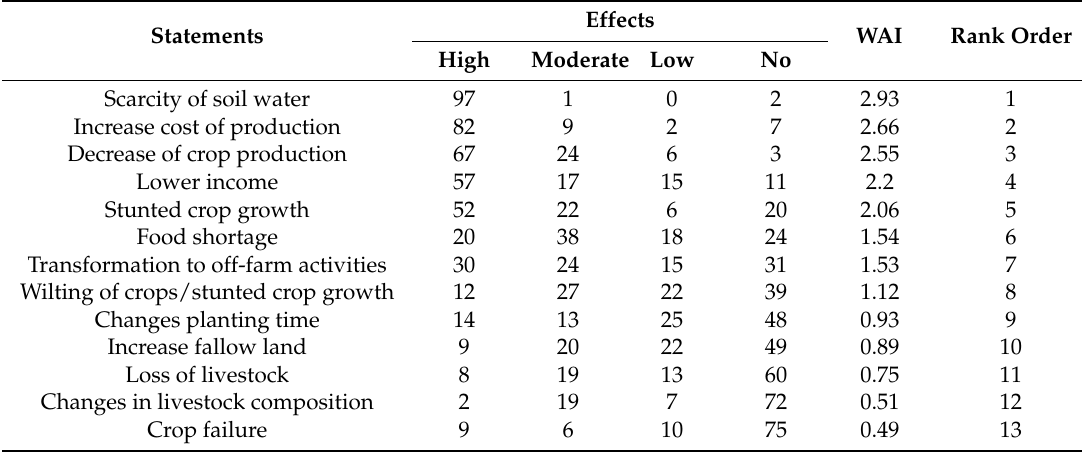
Table 2. Rank order of the farmers’ perceived effects of drought on agriculture ( n =